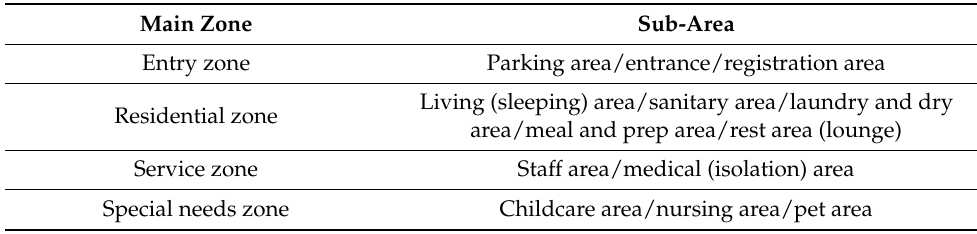
Table 2. Classification of temporary shelter